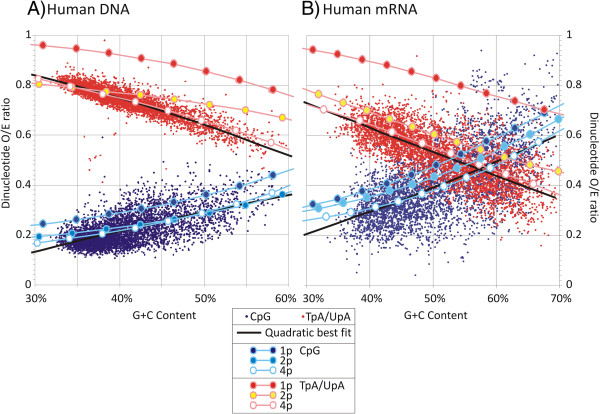
Observed / expected CpG and UpA frequencies in (A) human DNA and (B) mRNA sequences as a function of G+C content. Frequencies of each dinucleotide predicted from mutational models with 1, 2 and 4 parameters (1p, 2p and 4p, labelled according to the inset box) were superimposed on observed distributions of CpG and UpA dinucleotides (blue and red dots respectively; see inset box). Quadratic lines of best fit through observed distribution (black lines) were matched to model predictions over a G+C composition range from 20%-80%.